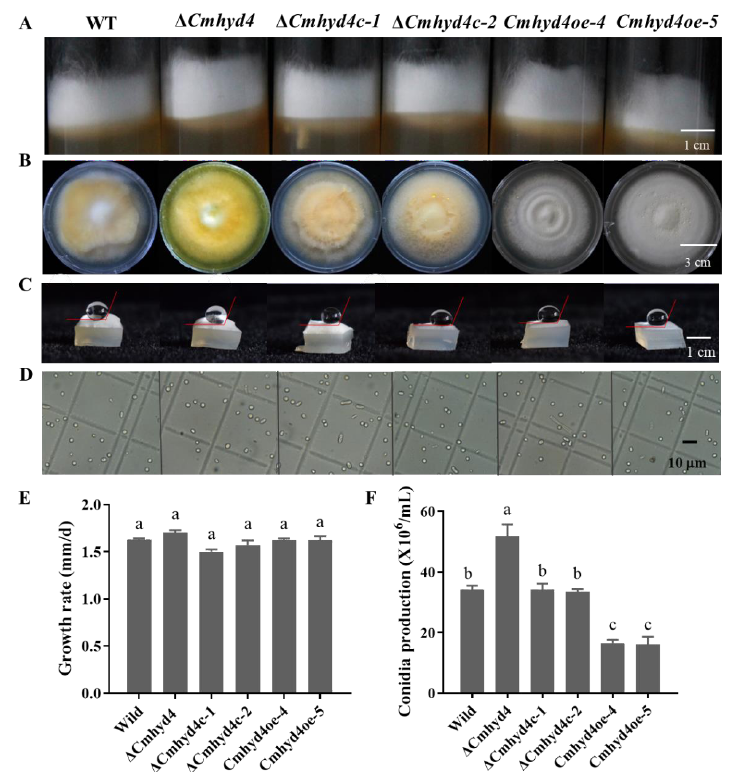
Figure 2. Morphology, growth rate, hydrophobicity, and conidiation in the WT and mutant strains. ( A ) Aerial mycelia: Aerial mycelia were cultured in a test tube with PDA medium at 20 °C in dark- ness. We observed them after culturing for 7 d. ( B ) Colony morphology: The colonies were cultured on PDA medium in darkness for 21 d at 20 °C. We observed them after exposure to light/dark (12/12 h) condition for 4 d. ( C ) The hydrophobicity of mycelia. ( D ) The hydrophobicity of conidia. ( E ) Growth rates. ( F ) Conidia production. Error bars represent the standard deviation (SD) of three rep- licates. Different letters above the bars represent significant differences ( p < 0.05).